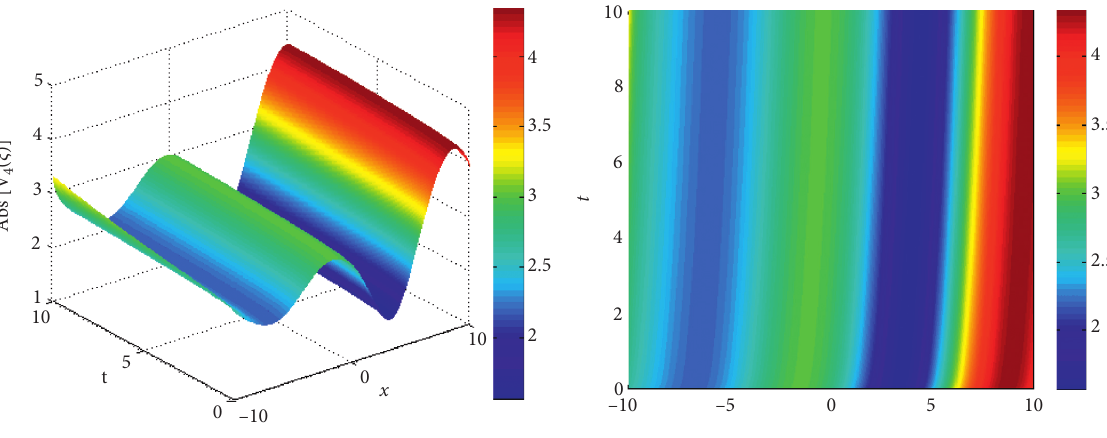
Figure 2: Soliton solutions of equation (29) in 3D and contour plots, where y � 2; k � 0.2; v � 0 . 2; α � 0.5; u � 3; λ � 4; a � 2; D �( λ 2 ) − ( 4 u ) ; � 2. and c 1